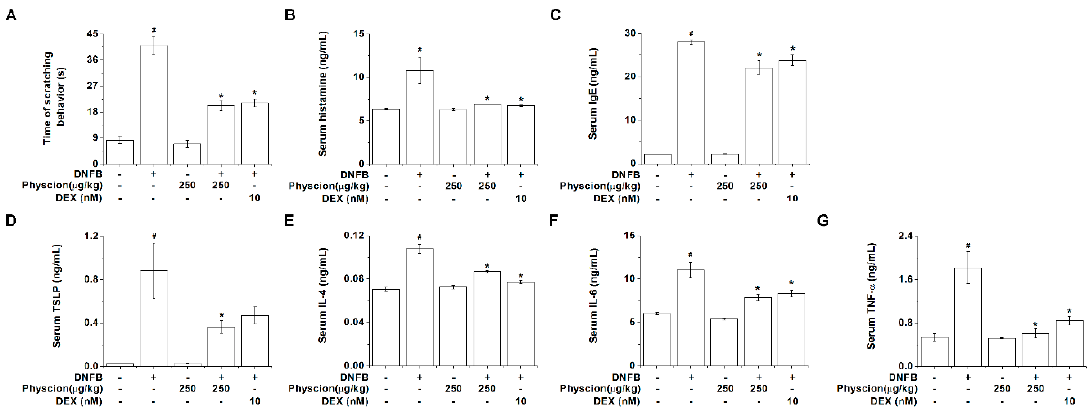
Figure 6. Physcion inhibits serum histamine, IgE, and TSLP levels in AD-like murine model. ( A ) The time of scratching behavior was measured for 10 min. ( B ) The serum histamine levels were analyzed with o-phthaldialdehyde spectrofluorometric procedure. The levels of ( C ) IgE, ( D ) TSLP, ( E ) IL-4, ( F ) IL-6, and ( G ) TNF- α in serum were detected by ELISA. # p < 0.05 vs. a vehicle group. * p < 0.05 vs. a DNFB control group.